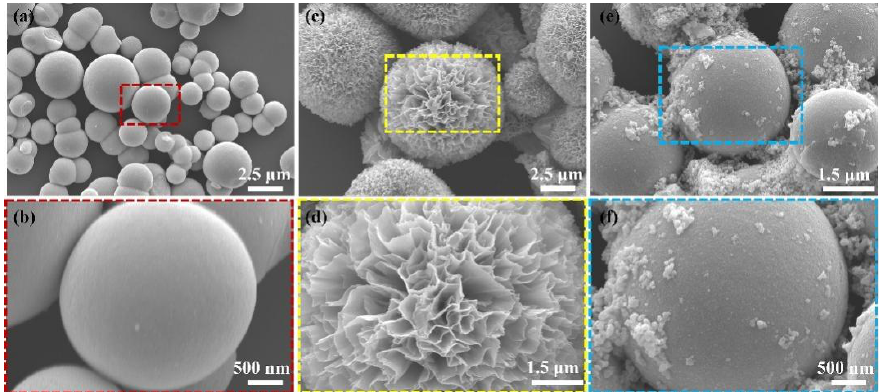
Figure 2. SEM images: ( a , b ) of the pure SnO 2 ; ( c , d ) of the prepared In 2 O 3 ; ( e , f ) of the prepared 1.0 wt.% In 2 O 3 /SnO 2 composite photocatalysts.